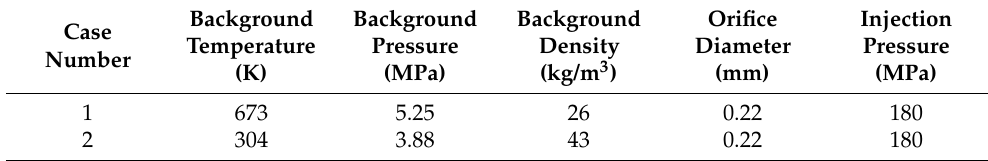
Table 7. Setting of experimental parameters.